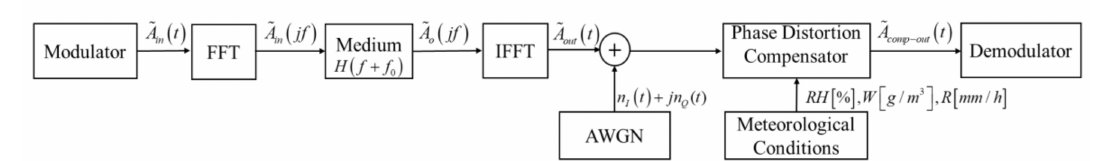
Figure 7. Flow chart of millimeter wave (MMW) link including Phase Distortion Compensator in the receiver